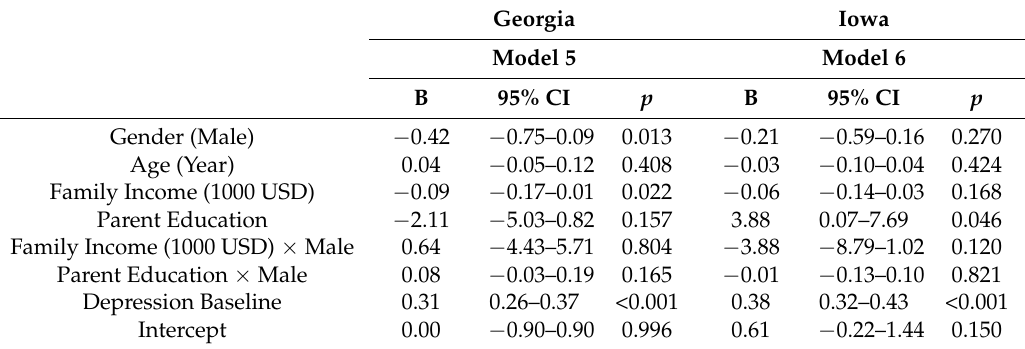
Table 5. Summary of linear regressions on the interactive effects of SES and gender on average depressive symptoms over 18 years by place ( n = 889).